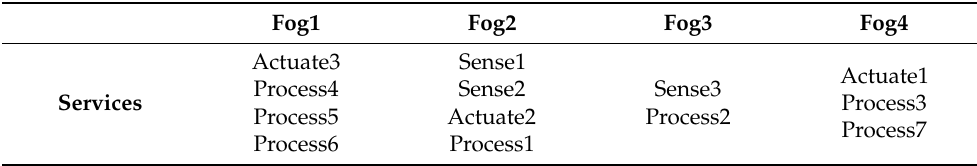
Actuate1 Process3